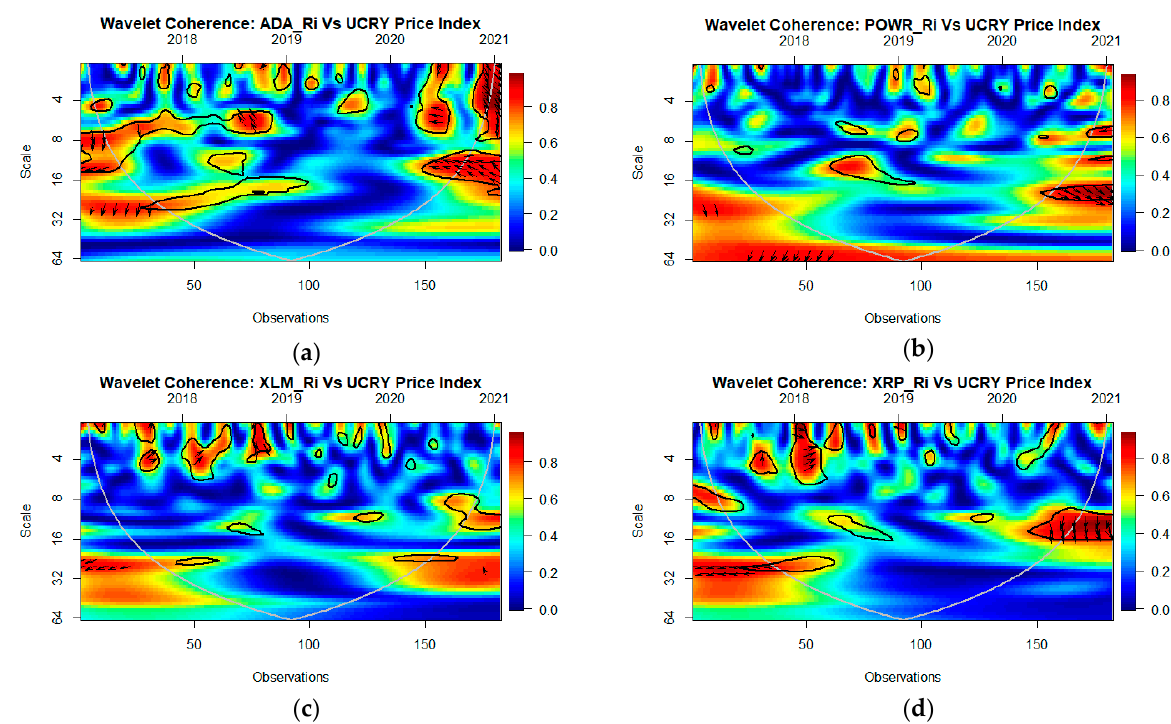
Figure 5. Wavelet coherence between sustainable cryptos and UCRY price index. Note: ( a ) = wavelet coherence between Cardano and UCYR Price Index, ( b ) = wavelet coherence between Powerledger and UCYR Price Index, ( c ) = wavelet coherence between Stellar and UCYR Price Index, ( d ) = wavelet coherence between Ripple and UCYR Price Index.